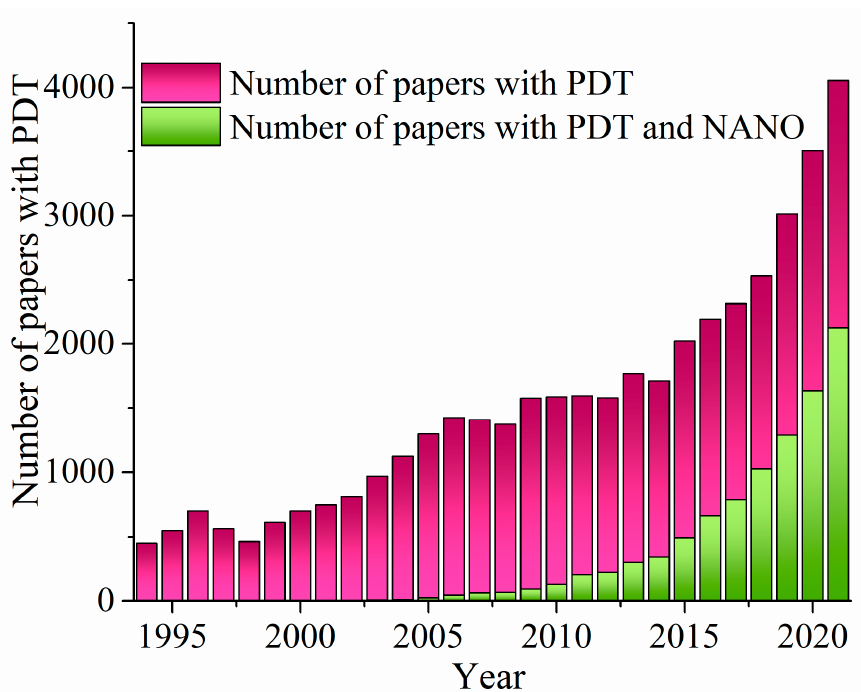
Figure 2. The number of published papers with “photodynamic therapy” as a keyword (violet) per year, and the number of papers published with the keywords “photodynamic therapy” and “nano*”, according to the Scopus database, on 1 October 2022.